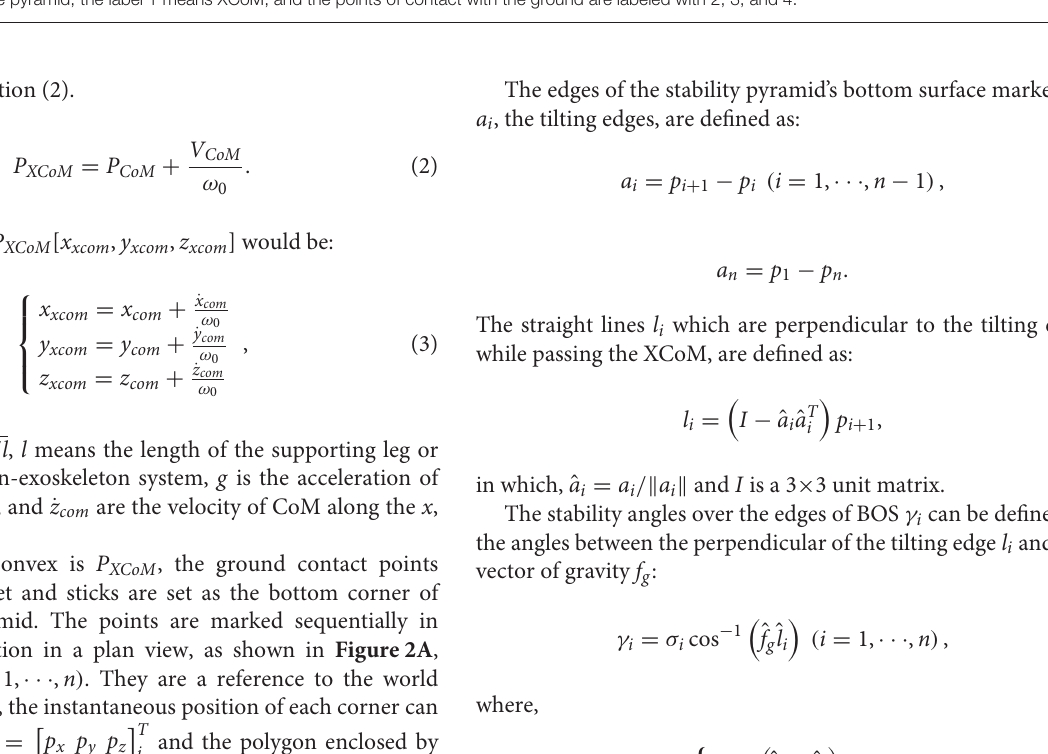
FIGURE 2 | The Enhanced Stability Pyramid Index (ESPI) demonstration and the index of the human-exoskeleton model. In (A) , an enhanced stability pyramid is composed of the bottom points noted p i and the vertex point—eXtrapolated Center of Mass (XCoM), which could be used to evaluate the safety status of a system. The stability angles over the edges and corners are marked as γ i and ψ i ( i = 1, ··· , n ). While in (B) , the pyramid of the human-exoskeleton to evaluate the system’s safety is shown. In the pyramid, the label 1 means XCoM, and the points of contact with the ground are labeled with 2, 3, and 4.